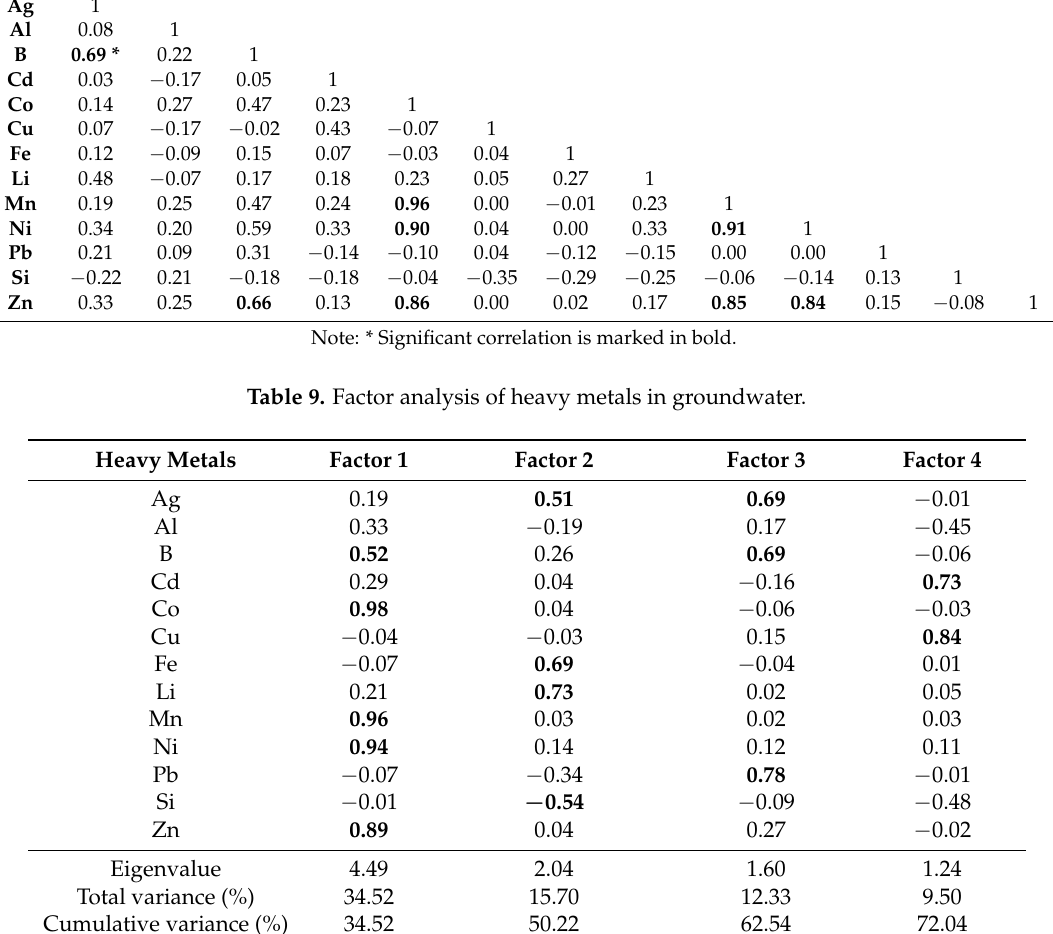
Table 9. Factor analysis of heavy metals in groundwater.